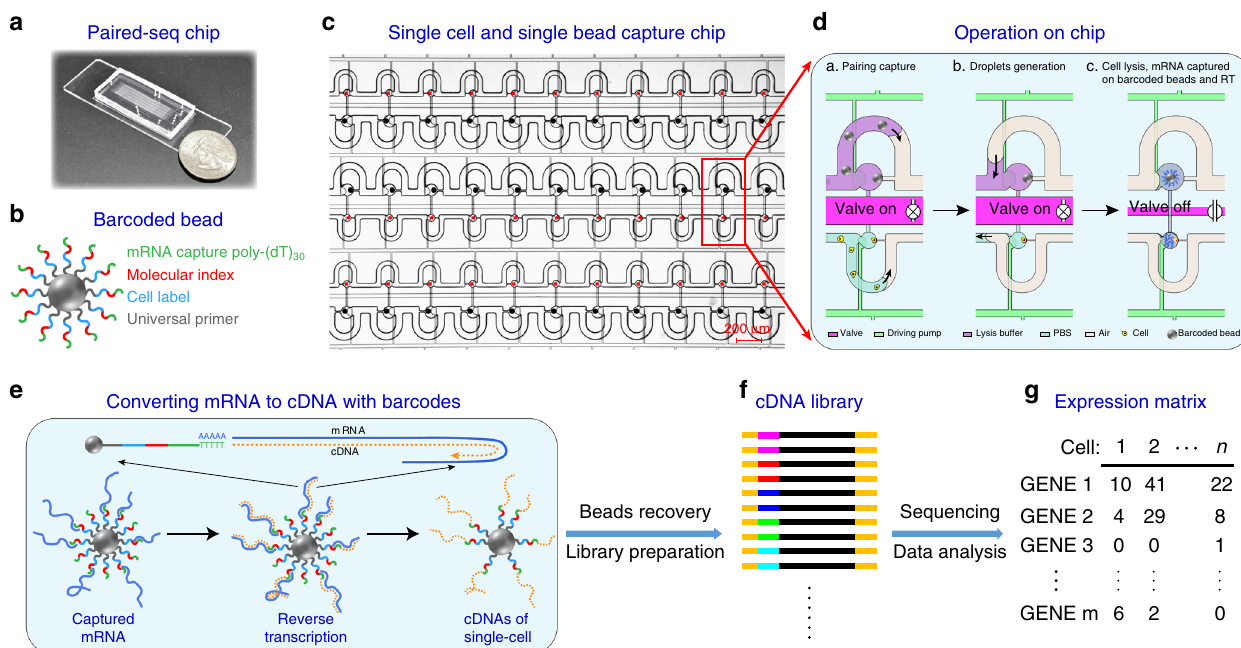
Fig. 1 Paired-seq: a Platform for DNA Barcoding scRNA-Seq. a Photograph of Paired-seq chip with a Quarter dollar coin. b Sequence of primers on the barcoded beads. The primers on beads contain mRNA capture poly-(dT) 30 , molecule index, cell label, and universal primer. c Schematic diagram of cell and barcoded bead pairing on Paired-seq chip. Scale bar is 200 μ m. d Schematic of the basic work fl ow for single cell and bead parallel manipulation on Paired- seq chip, including ( a ) capture and pairing of single cells and single beads ( b ) droplets generation to separate adjacent units ( c ) cell lysis and mRNA captured on barcoded beads. e After hybridizing to the primers on the barcoded beads, mRNAs are reverse-transcribed to produce cDNAs. All the cDNAs- attached beads are recovered from the chip and ( f ) subsequently ampli fi ed for library preparation in bulk. g Data analysis to generate single cell expression matrix. Millions of paired-end reads are generated from a Paired-seq library on a high-throughput sequencer. The reads are fi rst aligned to a reference genome to identify the gene of origin of the cDNA. Next, reads are grouped by their cell barcodes, and individual UMIs are counted for each gene in each cell. The result is a “ digital expression matrix ” that each column corresponds to a cell, each row corresponds to a gene, and each entry is the integer number of transcripts detected from that gene, in that